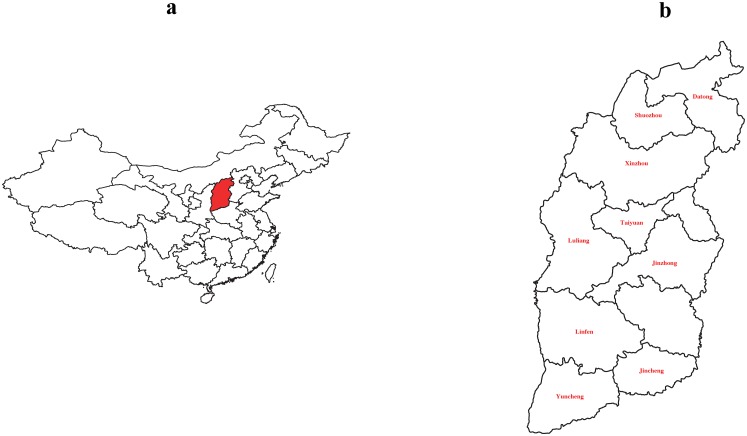
Survey locations map.Note: a. Map of China. The red area is Shanxi Province; b. Map of Shanxi Province. Taiyuan, Shuozhou, Jincheng, Jinzhong, Datong, Linfen, Lvliang, Yuncheng, and Xinzhou are presented. R V3.3.3 software, “maptools” and “ggplot2” packages were used to create this map. The relevant geographic data was downloaded from National Geomatics Center of China http://ngcc.cn/article//sjcg/mndxt/ freely.